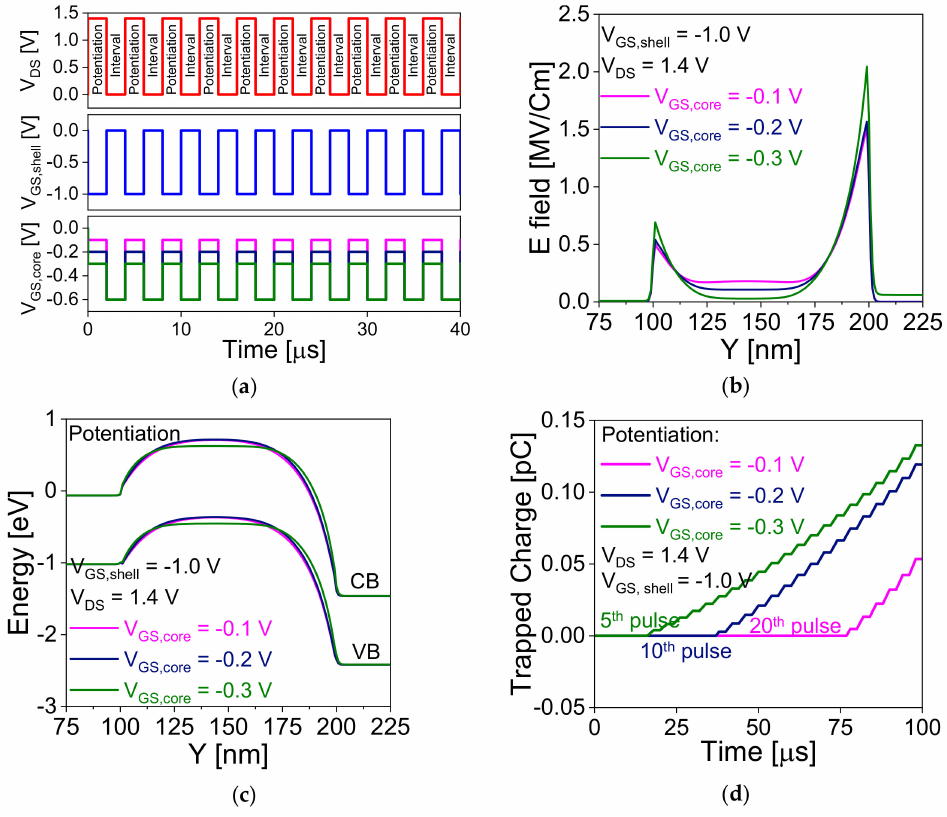
Figure 4. Potentiation operation. ( a ) voltage waveform during potentiation operation. Variation of ( b ) electric field (E filed) and ( c ) energy band diagram with core-gate voltage along the y-direction. ( d ) Variation of trapped charge for different V GS,core . E field and energy band diagram are extracted 1 nm below of the core gate